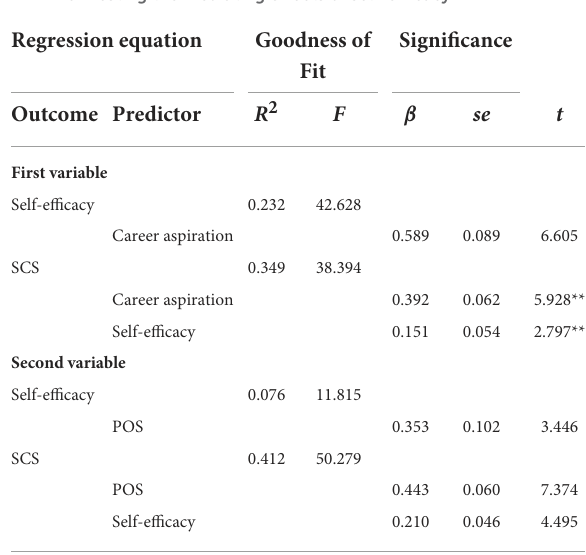
TABLE 3 Testing the mediating effects of